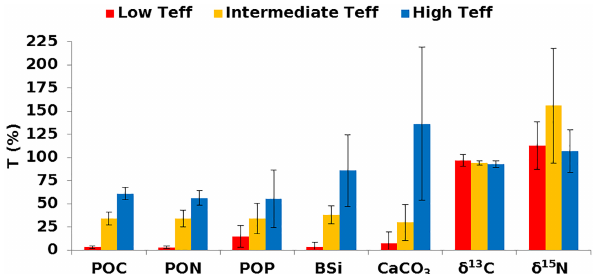
Figure 7. Mean transfer efficiency for the main components of the particle fluxes (related to POC, PON, POP, BSi, CaCO 3 , and partic- ulate δ 13 C and δ 15 N), as a function of the three main T eff ranges de- fined from POC fluxes. The transfer efficiencies for PON ( T effPON ), POP ( T effPOP ), BSi ( T effBSi ), CaCO 3 ( T effCaCO ), δ 13 C ( T ) eff 13 C 3 and 15 N ( T ) are derived from Eq. (1), as for T eff . Error bars eff 15 N represent the associated standard deviation of the elemental transfer for the considered T eff ranges (more details in Table